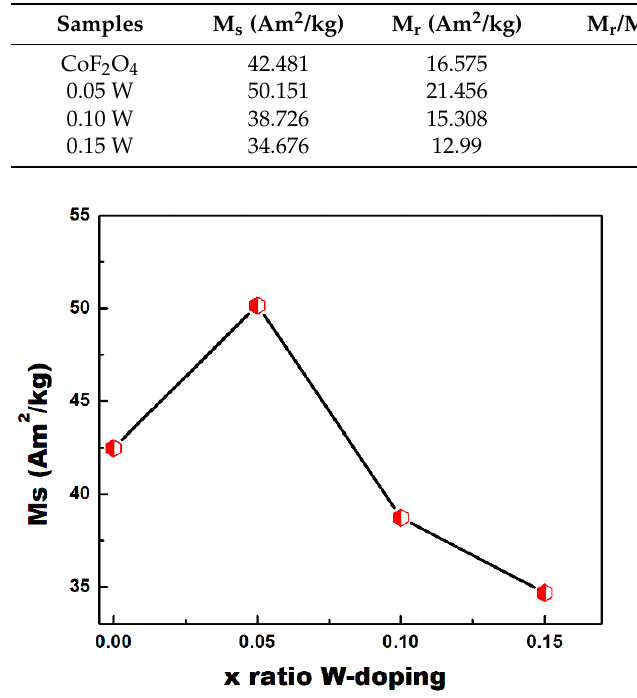
Figure 11. Variation of saturation magnetization (Ms) with W-doping level. Table 4. The magnetic properties of the CoW x Fe 2-2x O 4 samples.